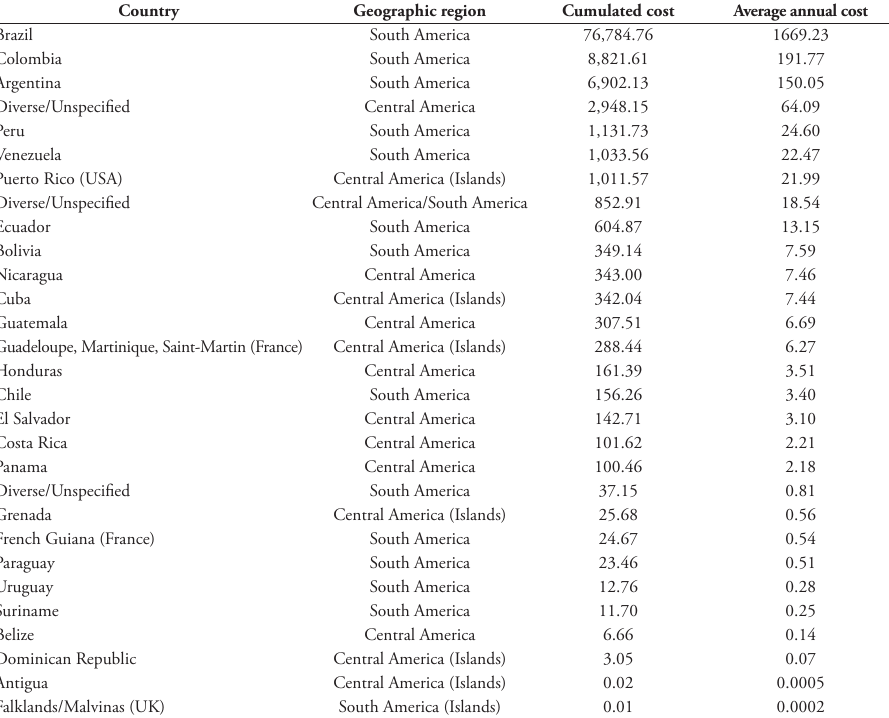
Table 1. Reported economic costs of biological invasions between 1975 and 2020 in the countries of Central, South America and the Caribbean Islands (USD million). The Table is ordered from the country with highest cost to lowest cumulated cost.